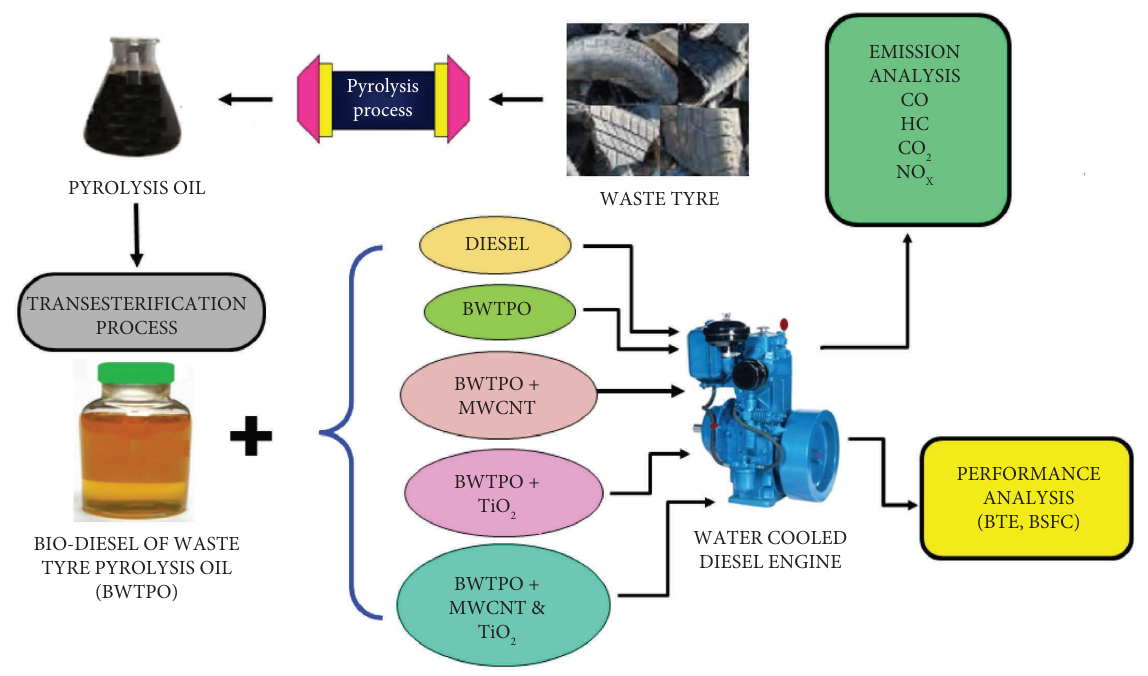
Figure 1: Schematic representation of this study.